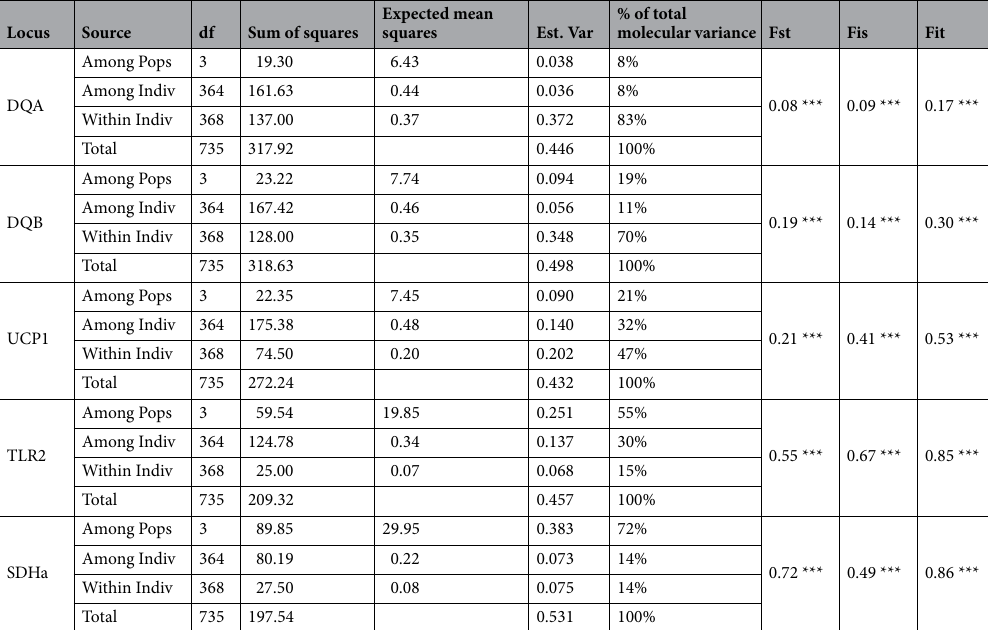
Table 2. Analysis of molecular variance (AMOVA) for each locus. Populations used in this analysis have been partitioned as follows: brown hare allopatric, brown hare sympatric, mountain hare allopatric, mountain hare sympatric population. P-values are based on 999 random permutations. *** p < 0.001.